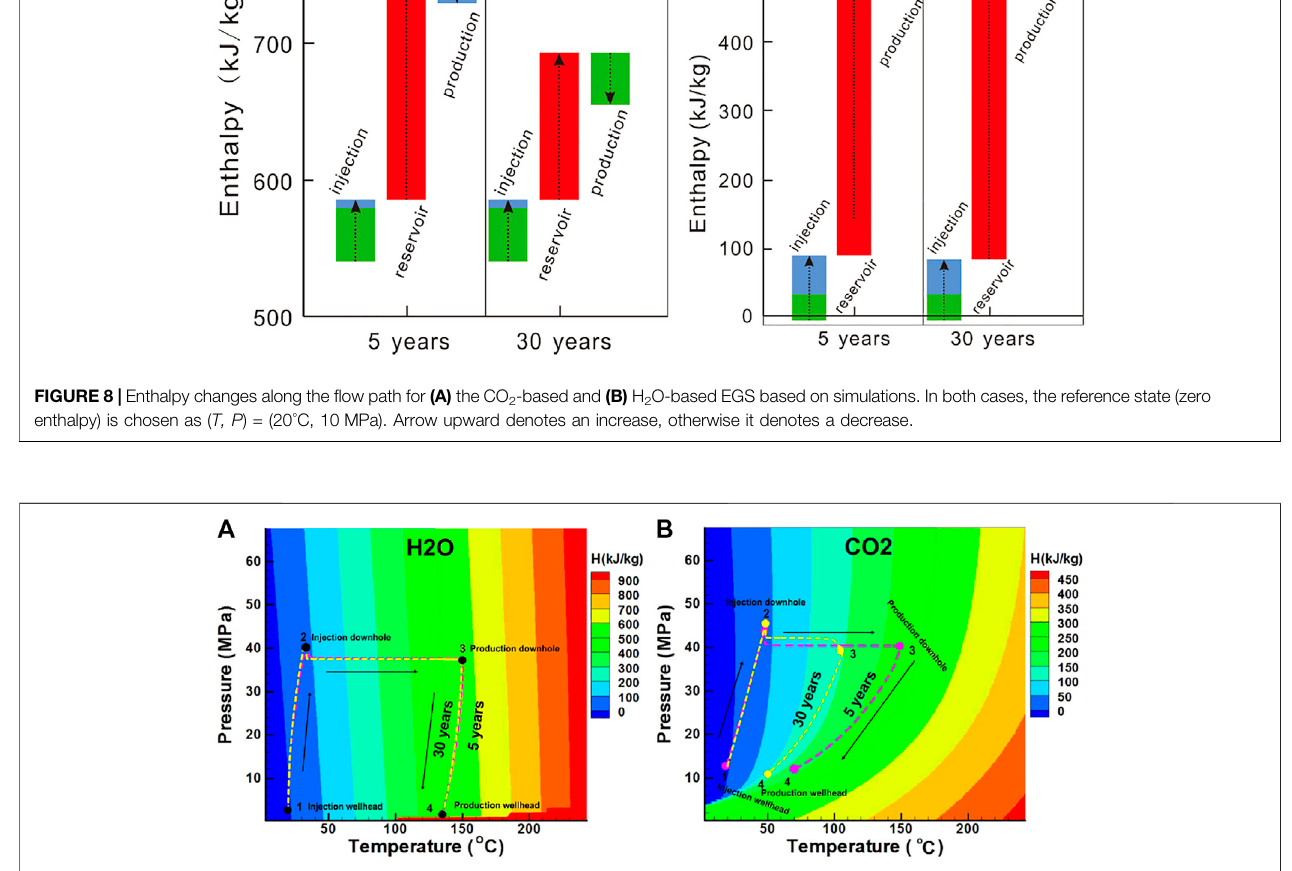
FIGURE 9 | State ( P, T, E ) change along the fl ow path for (A) the H 2 O-based and (B) CO 2 -based EGS.